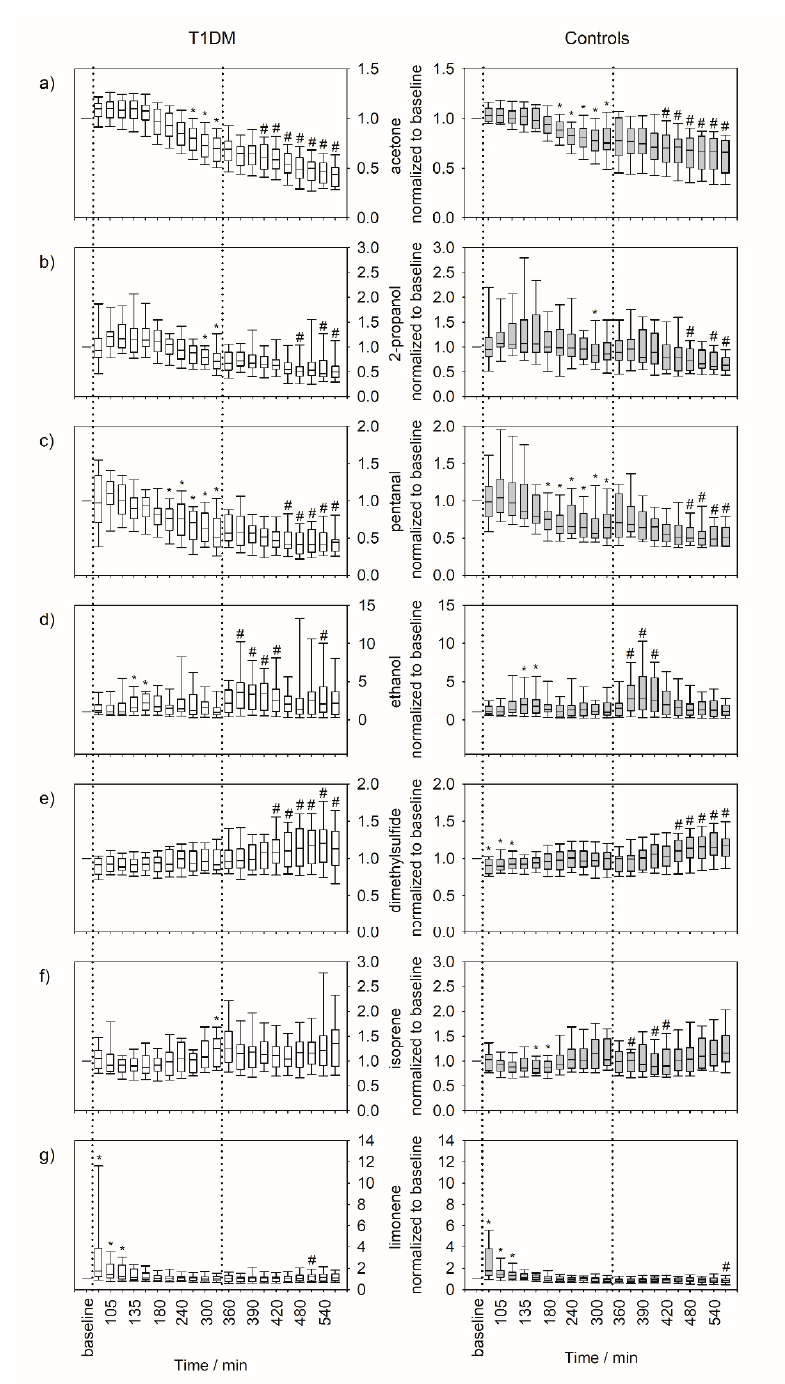
Figure 4. Box plots of breath VOCs over a course of nine hours. ( a ) Acetone, ( b ) 2-propanol, ( c ) pentanal, ( d ) ethanol, ( e ) dimethyl sulfide, ( f ) isoprene, and ( g ) limonene. The graphs on the left show the course over of the nine hours of the experiment for T1DM patients ( n = 22), the graphs on the right show the corresponding data from healthy controls ( n = 22). Data were normalized to the baseline value (before breakfast) to emphasize relative changes and minimize inter-individual variation. Lunch was taken after the measurement at the 330th minute. Dotted lines indicate intake of standardized meals. Asterisks (*) indicate statistically significant changes versus baseline (before breakfast) and hashes (#) indicate statistically significant changes versus the 330th minute (last measurement before